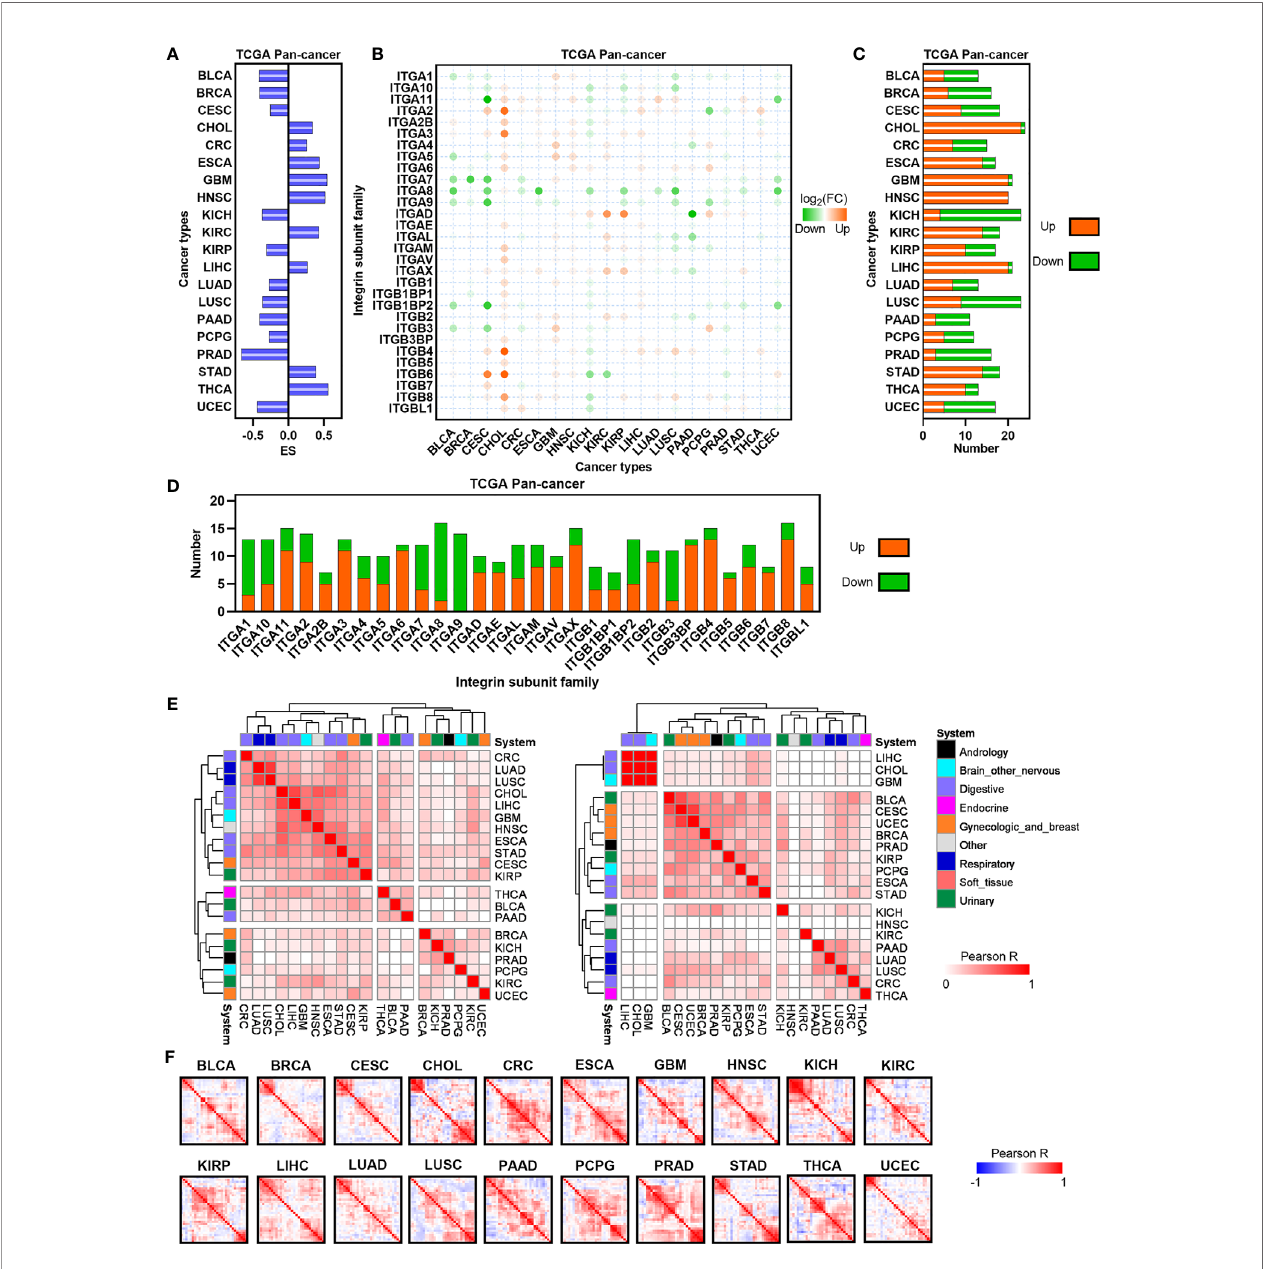
FIGURE 1 | Expression landscape of ITGs in human cancers. (A) Barplot depicting the GSEA performance for ITGs set in TCGA tumor and normal samples. (B) Heatmap showing the FC of ITGs across multiple cancers from the TCGA. (C) The number of signi fi cantly dysregulated ITGs for each cancer from the TCGA. (D) Barplot showing the distribution of dysregulated ITGs across multiple cancers from the TCGA. (E) Heatmap visualizing the matrix of Jaccard indices of the shared connections for the upregulated (left) and downregulated (right) ITGs of each cancer from the TCGA. Hierarchical clustering was performed in the matrix. (F) Heatmap showing the correlation levels among ITGs in each TCGA cancer